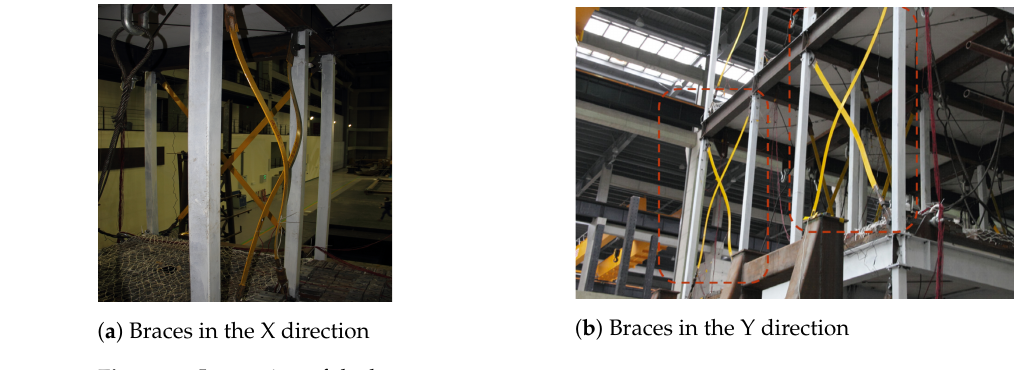
Figure 6. Loosening of the braces. Table 1. Structural information and damage patterns recorded under earthquake loading (UD: undamaged, PL: partial braces loosened, and AL: all braces